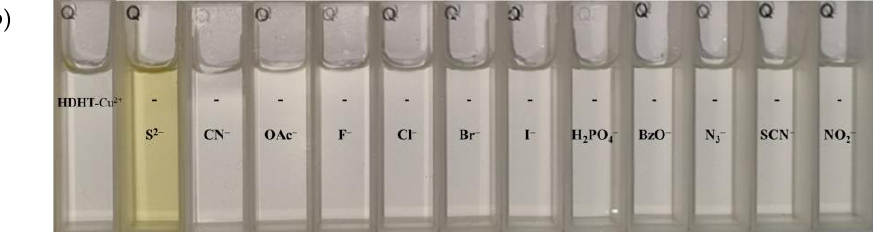
Figure 6. ( a ) Absorbance spectra of HDHT – Cu 2+ (30 μM) with a variety of anions ( 51 μM ). ( b ) Pho- tograph of color changes of HDHT – Cu 2+ (30 μM) with a variety of anions ( 51 μM ).